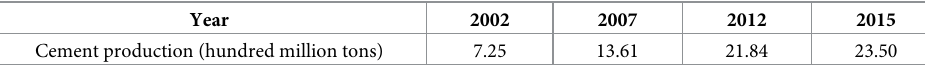
Table 6. The output of cement production from 2002–2015 in China.